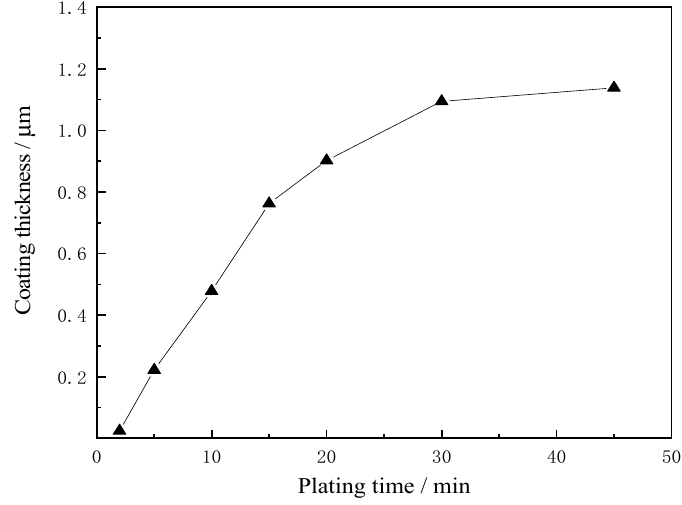
Figure 6. Variation of coating thickness with plating time.